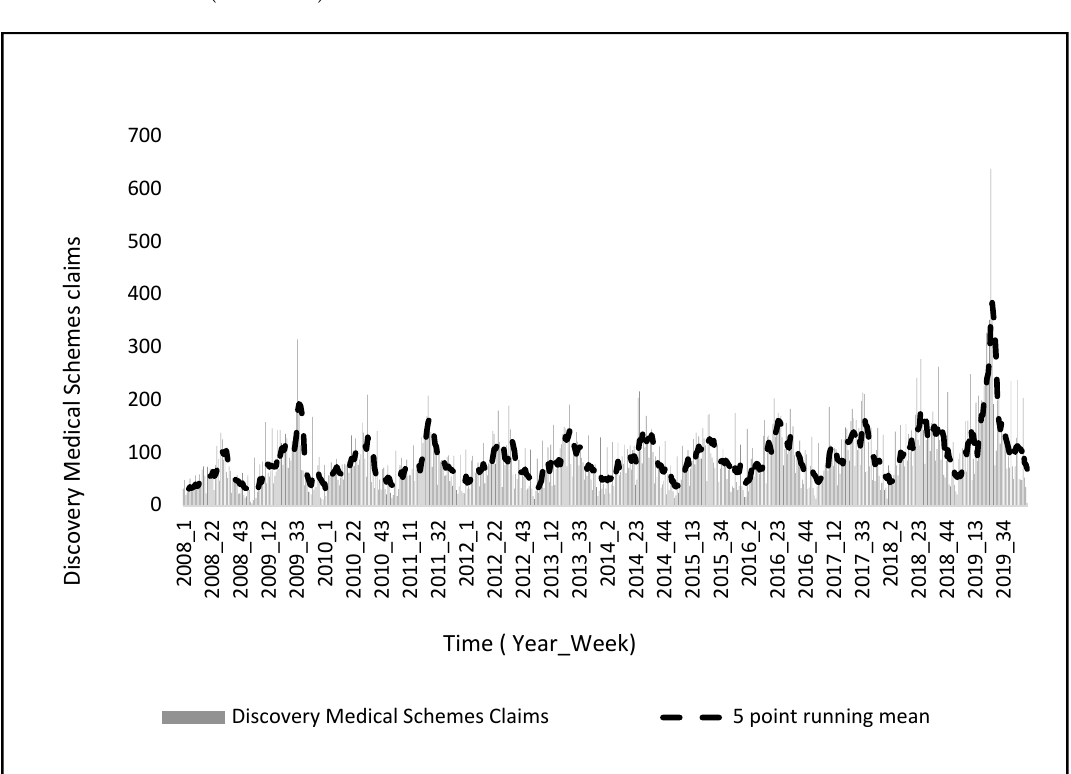
Figure 4. Discovery medical scheme claims in Gauteng, with a 5-point running, mean.